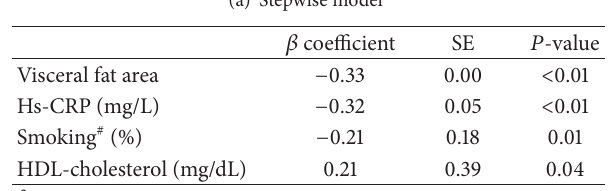
Table 3: Multiple regression analyses for mtDNA copy number # .